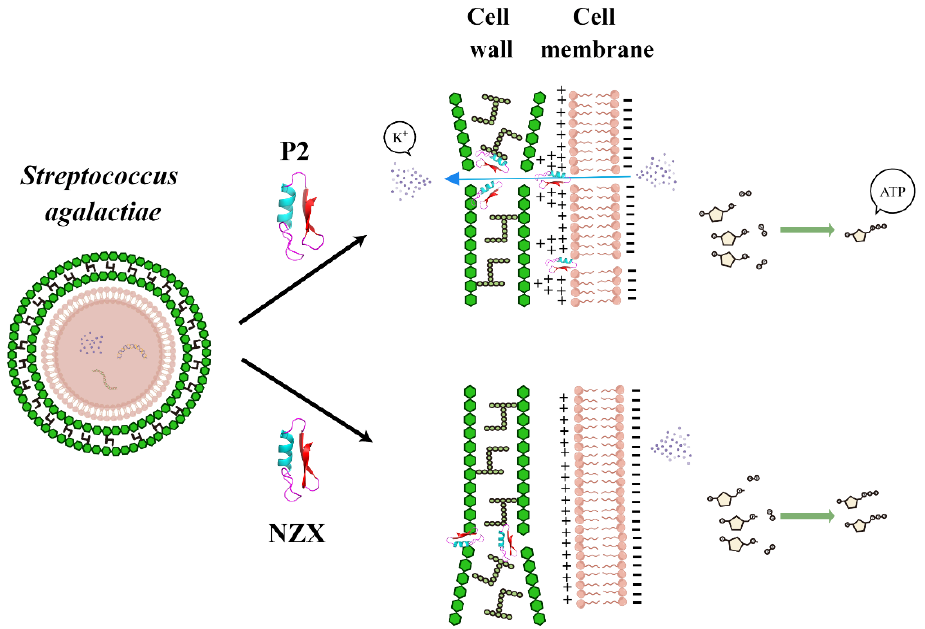
Figure 5. Mode of actions of NZX and P2 against S. agalactiae ACCC